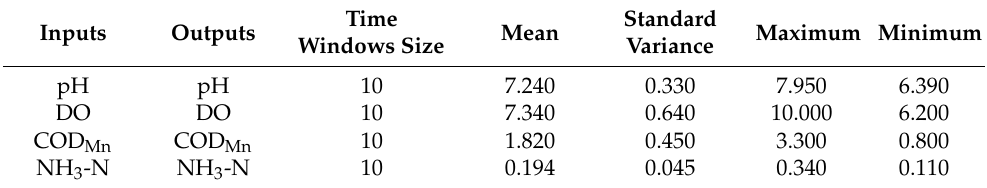
Table A2 shows the details of input-output parameters. Table A2. The details of input-output